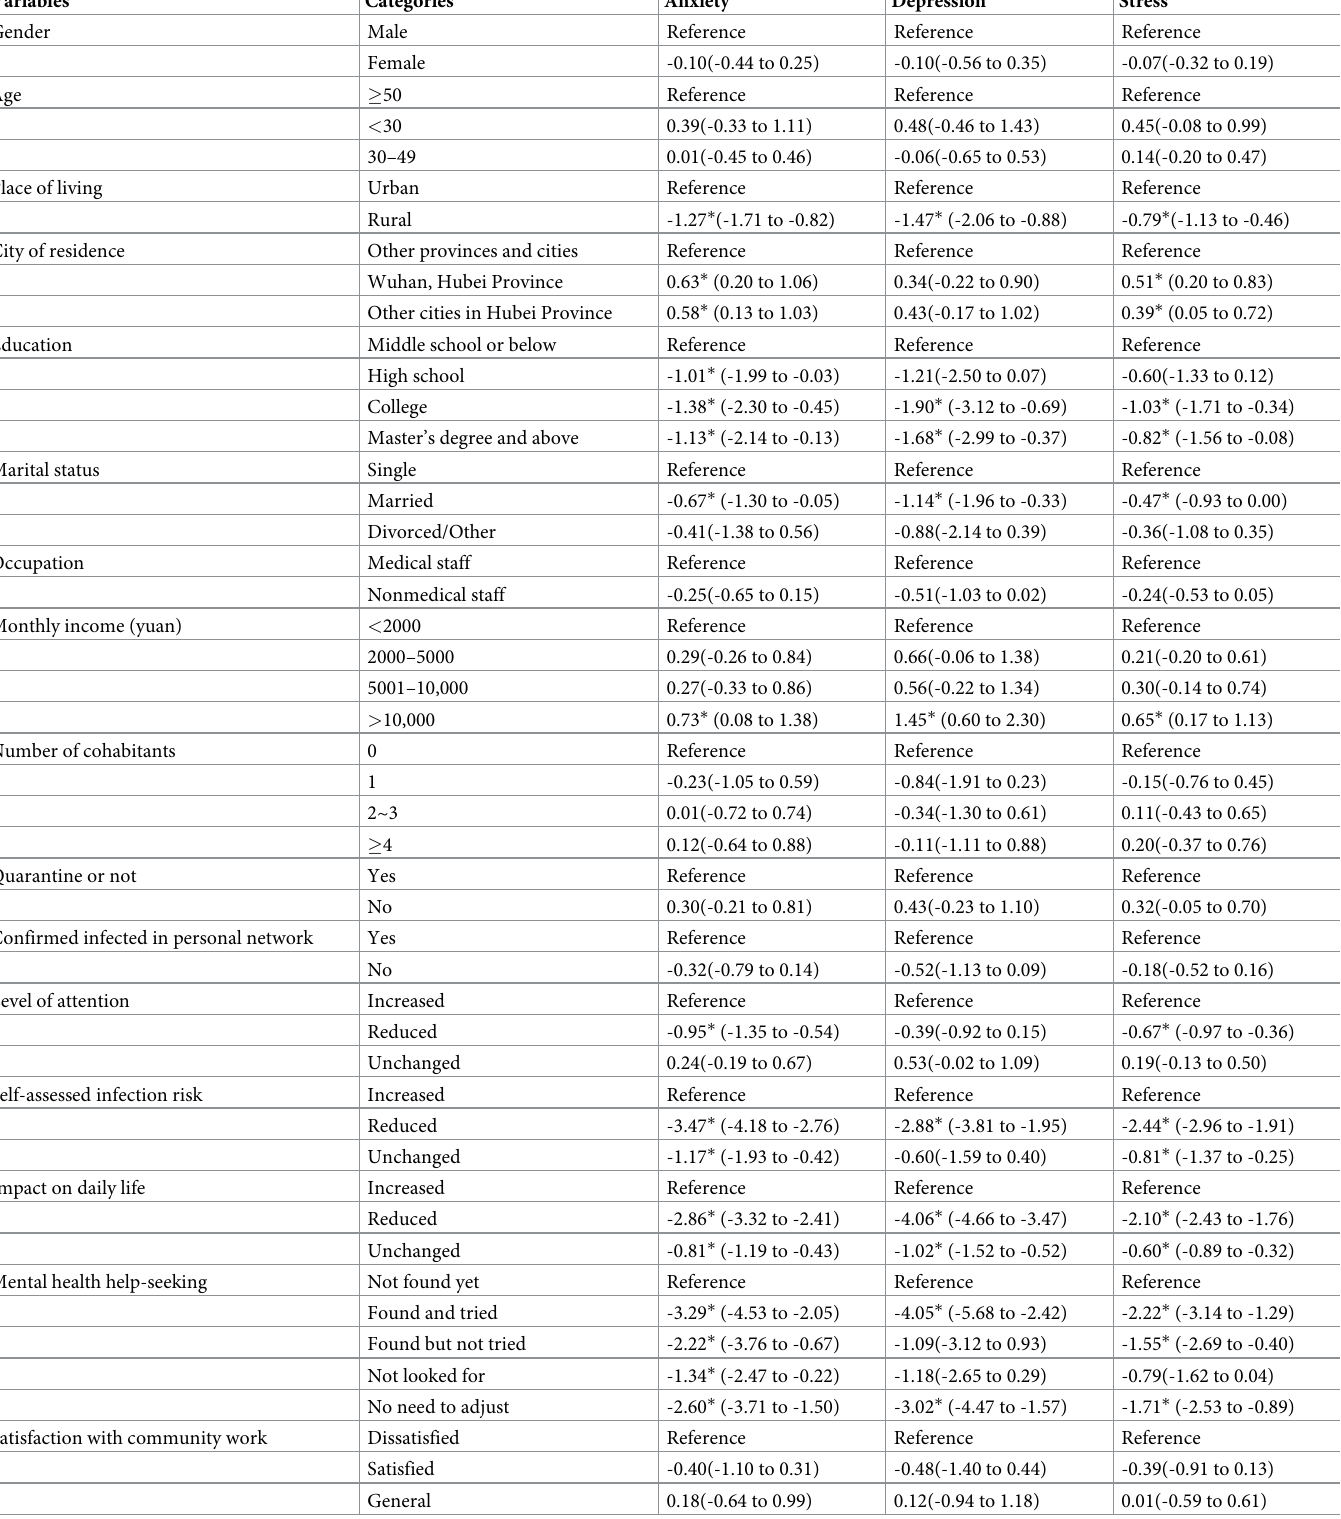
Table 2. Multivariate regression model for factors associated with anxiety, depression, and